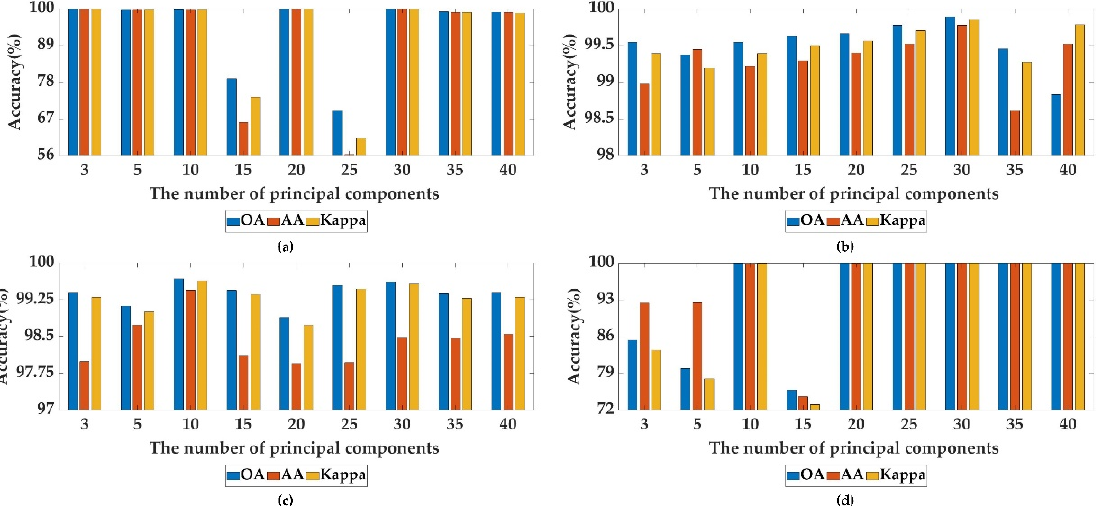
Figure 12. The classification results of different number of principal components. ( a ) on the SAC dataset, ( b ) on the UP dataset, ( c ) on the IP dataset, ( d ) on the SA dataset.